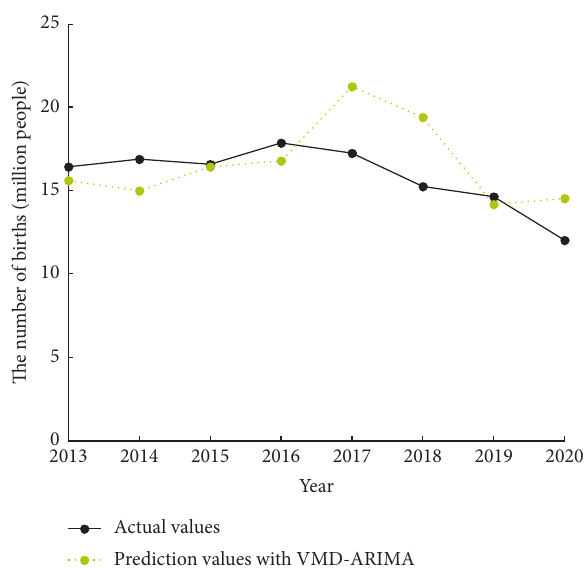
Figure 1: The actual China’s birth population and the prediction results for China’s birth population with